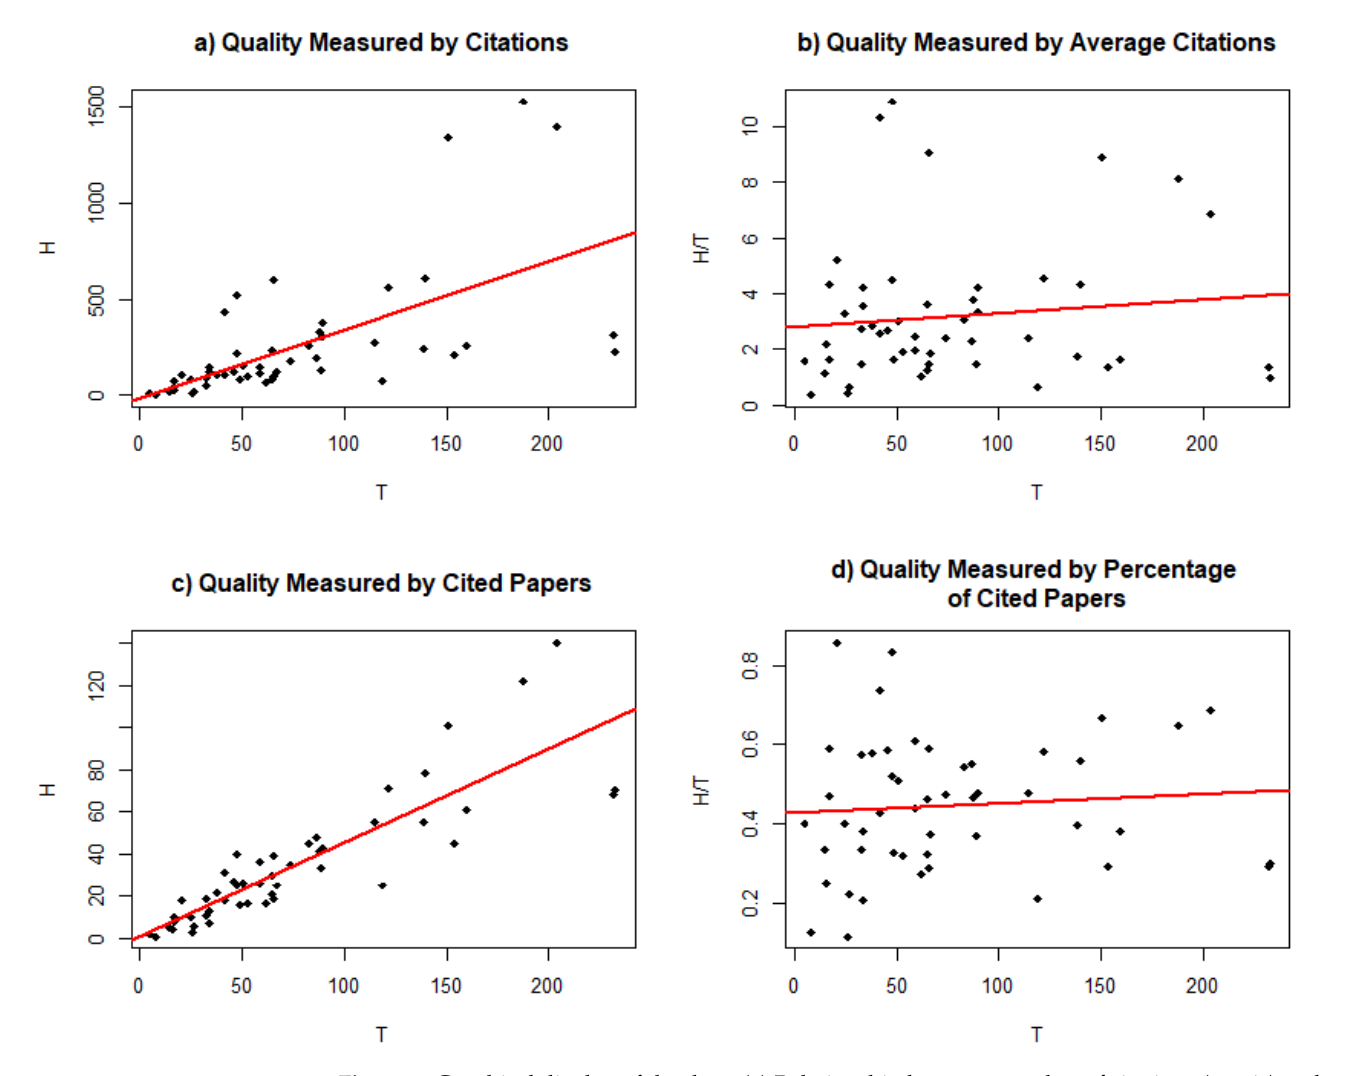
Figure 1. Graphical display of the data: ( a ) Relationship between number of citations (y-axis) and number of first-authored papers (x-axis); ( b ) relationship between average number of citations (y-axis) and number of first-authored papers (x-axis); ( c ) relationship between number of cited first-author papers and number of first-author papers; and ( d ) relationship between percentage of cited first-author papers (y-axis) and number of first-author papers. Red line depicts the ordinary least squares regression slope.